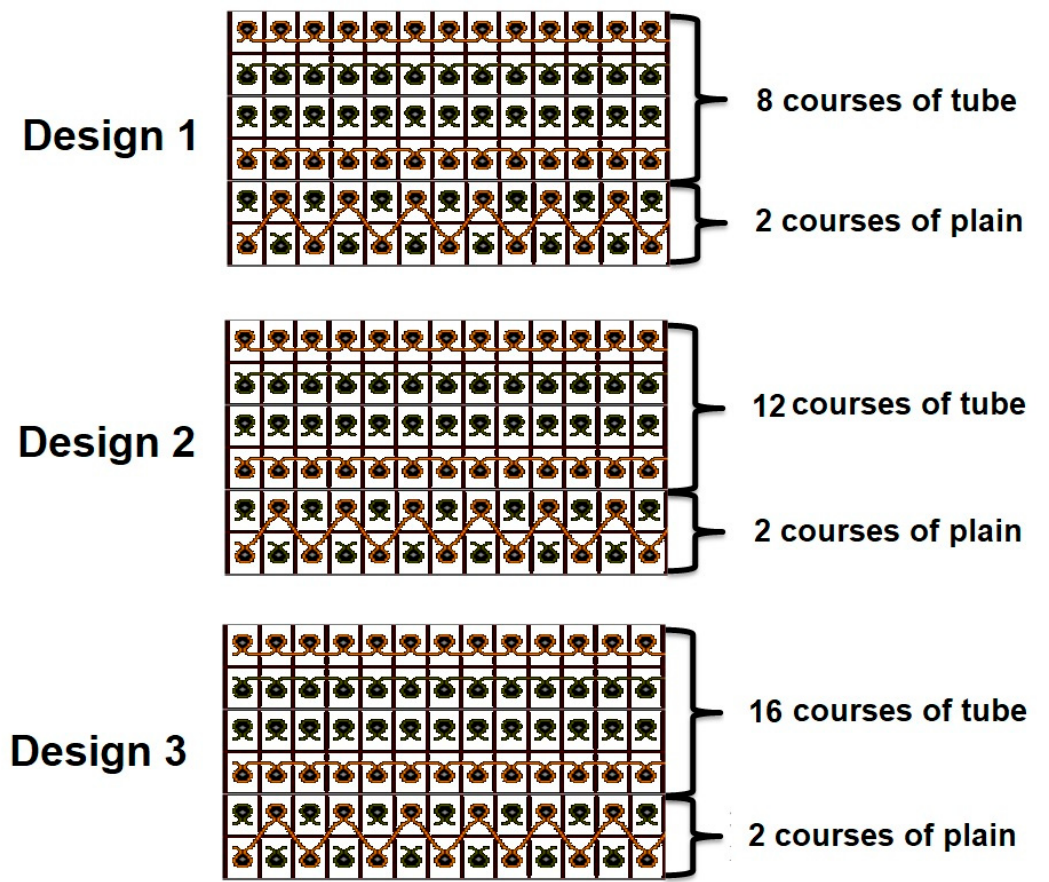
Figure 1. Knitting design (short representation).